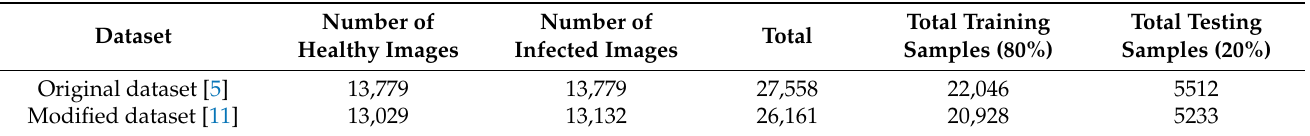
Table 1. Data distribution in the dataset used in this